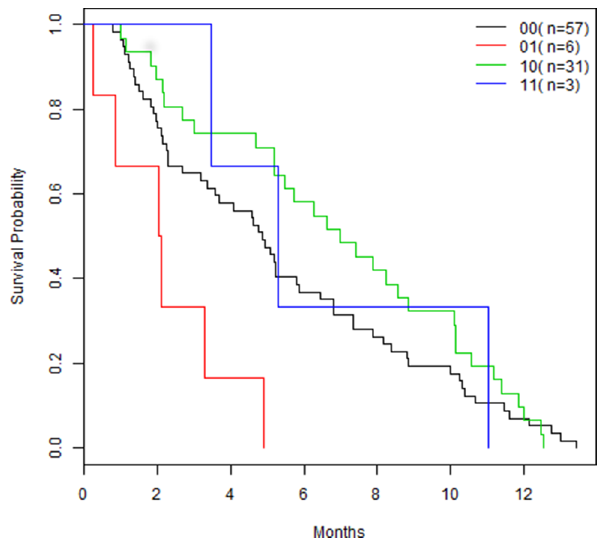
Figure 5. The prediction model divided the 97 patients into four subgroups using SVM. The logrank test for differences among the four subgroups (0,0), (0,1), (1,0), and (1,1) was 0.003.